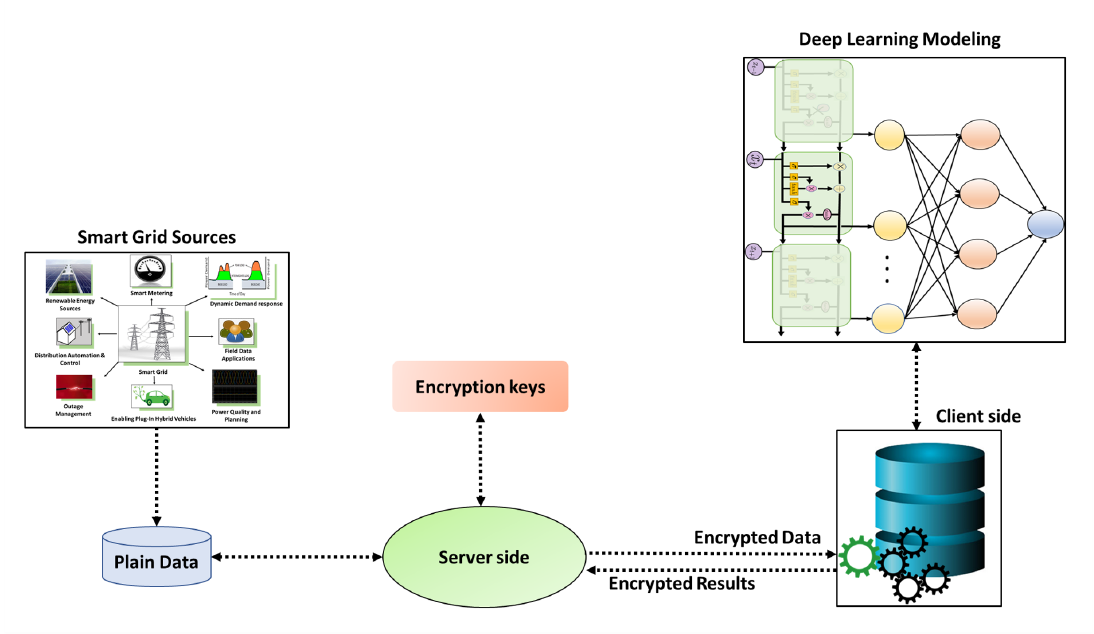
Figure 2. Homomorphic encryption-based deep learning modeling for smart grid